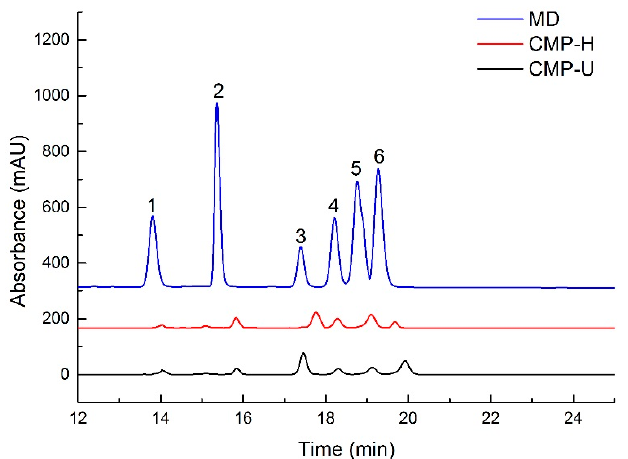
Figure 3. HPLC chromatogram of monosaccharides in CMPs. MD: mixed standard of monosaccharides; 1: fructose; 2: rhamnose; 3: glucose; 4: galactose; 5: xylose; 6: arabinose; CMP-H: C. morifolium polysaccharides obtained by hot reflux extraction; CMP-U: C. morifolium polysaccharides obtained by ultrasonic assisted extraction.